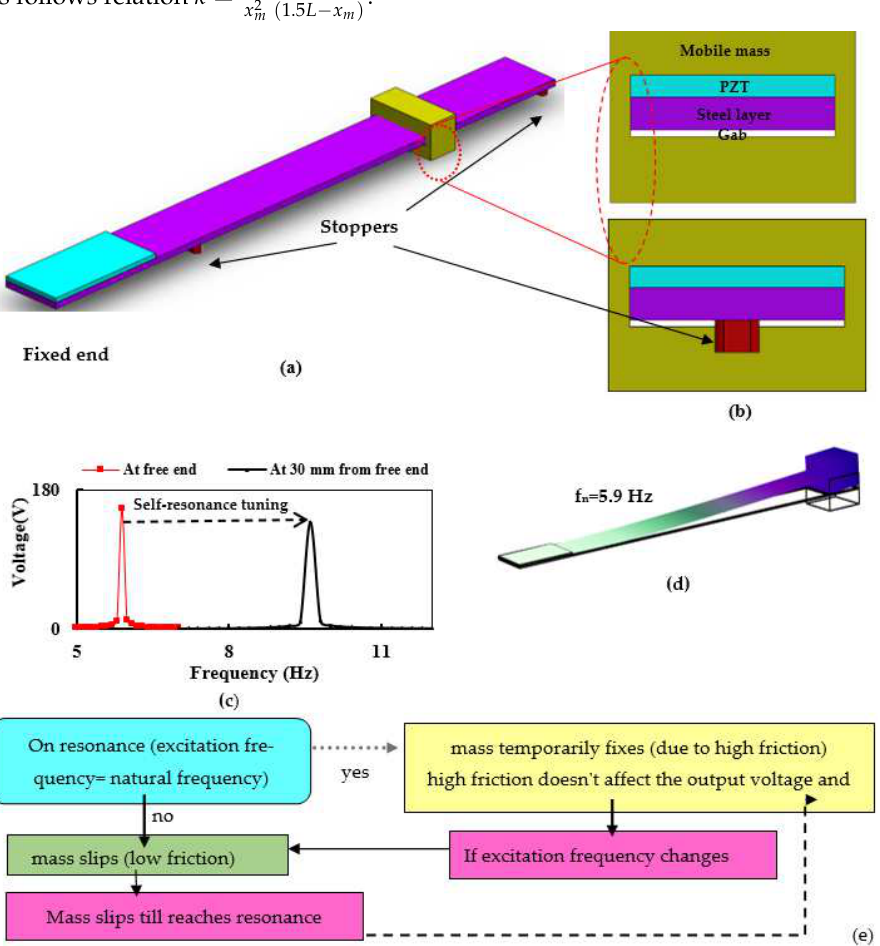
Figure 8. ( a ) Schematic diagram of the piezoelectric harvester with the mobile (sliding) mass. The natural frequency of the harvester can be tunable based on the mobile mass position, ( b ) the cross- section of the mobile mass, ( c ) self-resonance tuning using displacement difference, ( d ) first mode shape, and ( e ) flow chart of ART technique.